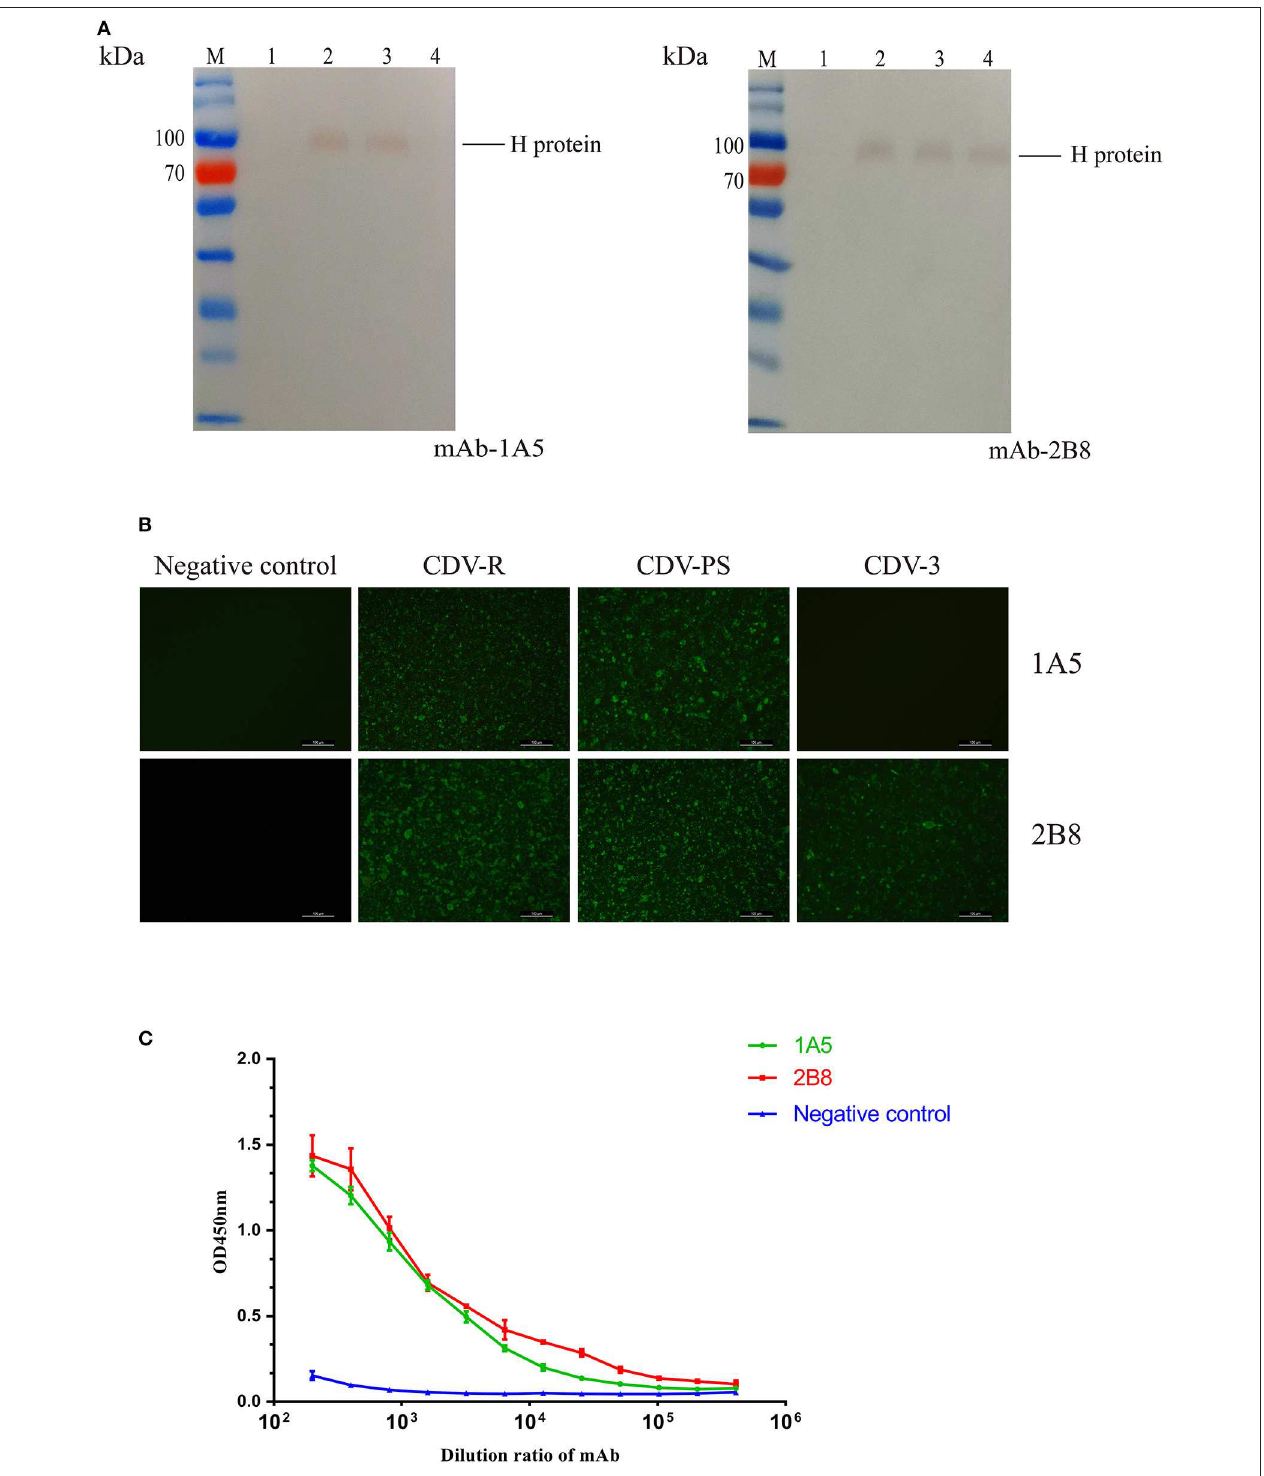
FIGURE 1 | Characterization and identification of the mAbs. (A–C) The immunoreactivity of native canine distemper virus (CDV) H protein to the mAbs was analyzed with western blotting. (A) Lane M: PageRuler TM Prestained Protein Ladder (Thermo Scientific); lane 1, cell lysates of uninfected Vero cells; lane 2, cell lysates of CDV-Rockborn–infected Vero cells; lane 3, cell lysates of CDV-PS–infected Vero cells; lane 4, cell lysates of CDV3-infected Vero cells. The mAbs are labeled at the right under each panel. (B) The mAbs recognized CDV-infected Vero cells by immunofluorescence assay (IFA). The cells were uninfected and infected with CDV. After 36h, the cells were primed with 1A5 and 2B8. (C) Binding affinities of the mAb 1A5 and mAb 2B8 determined by indirect ELISA with CDV-PS strain. The value of OD 450 nm is shown as a function of the respective dilution ratios of mAbs. The negative control used mAb against canine parvovirus.